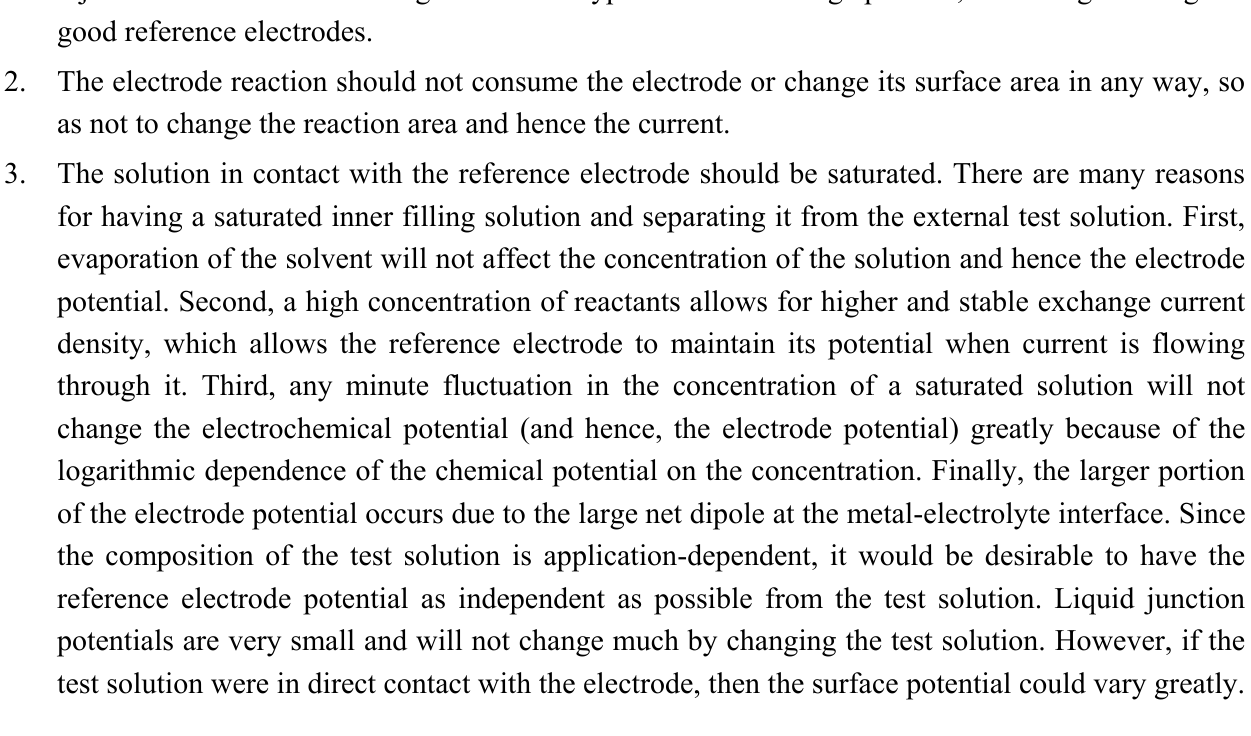
Figure 2. Symmetric I-V curves for electrodes of varying